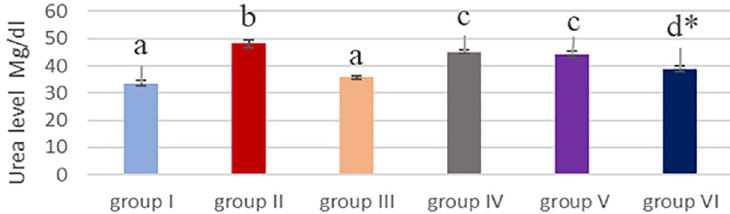
Figure 3. Showing effect of cyanocobalamin on plasma urea level. - Each value represents mean (cid:3) standard error of means (SEM) (N=7/Group), - Values expressed in non-identical letters (a, b,c ,d) are significantly difference (P<0.05), - *Highly significant difference from MTX